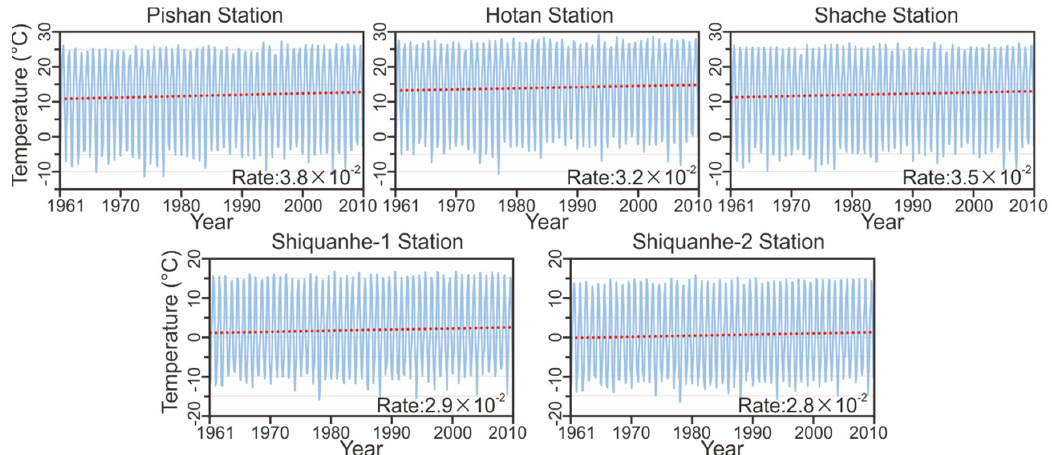
Figure 7. Mean monthly temperature records from GHCNm of five surrounding meteorological stations from 1961 to 2010. Their tendencies are shown in red dashed lines. The unit of change rate is °C a -1 .